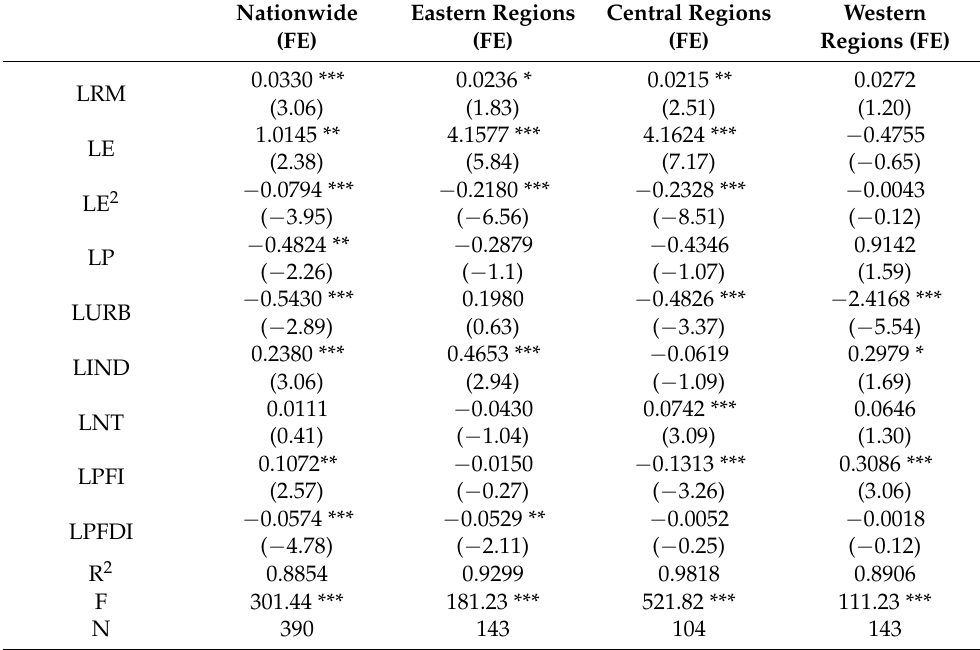
Table 7. Results for the impact of LRM on the carbon emission